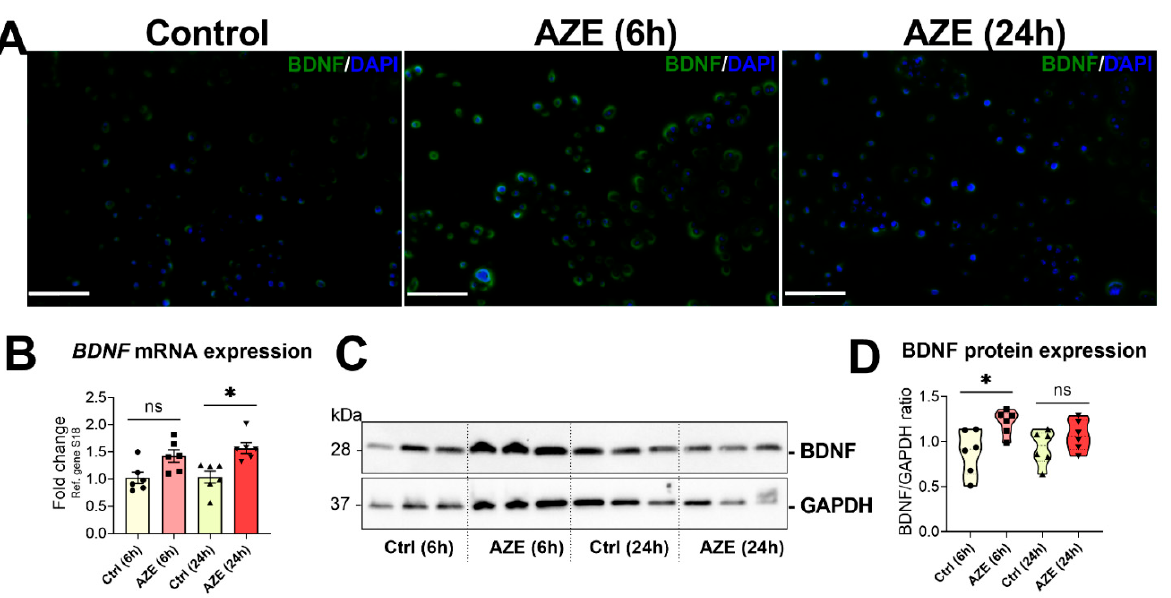
Figure 6. AZE treatment induces BDNF expression in BV2 cells. ( A ). Representative photomicrographs of BDNF+ staining in the BV2 microglial cell line. Cells were either left untreated or treated with AZE as indicated and then processed for immunocytochemistry (ICC) as detailed in Section 2. Red = BDNF+ cells (Alexa Fluor 488). DAPI = nuclei. Scale bar = 50 µm. ( B ). BDNF transcript levels, as determined by real-time qPCR. Fold changes were calculated using the Δ Ct method. Data is the mean ± SEM (n = 6). * p < 0.05 vs. Ctrl at the indicated time points. ( C , D ) Western blot analyses of Iba protein expression and densitometric analyses of blots. Data reported is the mean ± SEM, from two independent experiments using separate batches of cells (n = 6). GAPDH was used as loading control. Ns = not significant. * p < 0.05 vs. Ctrl at the indicated time, as determined by ANOVA followed by Sidak’s post hoc test.